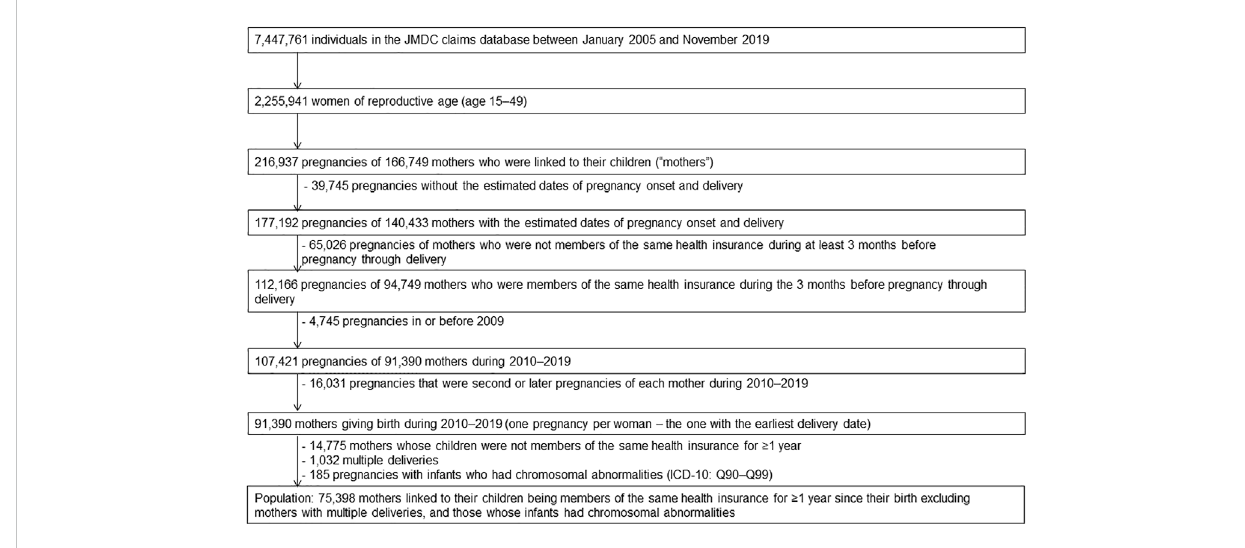
FIGURE 1 Flow chart outlining the study population selection.